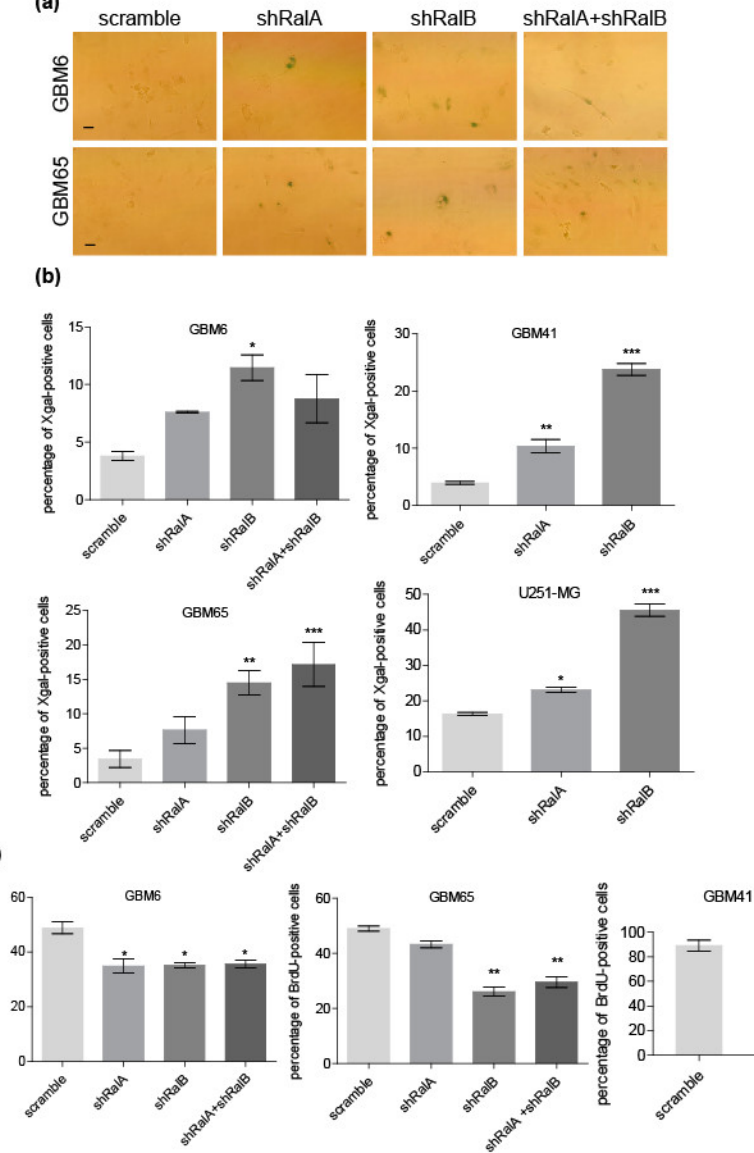
Figure 4. Downregulation of Ral GTPases promotes a senescence-like response in glioblastoma cells. Ral GTPases RalA and RalB were downregulated by RNA interference—shRalA and shRalB, respectively. Scramble shRNA was used as a control. GBM cells were infected by lentiviral vectors harboring the shRNAs. Five days after infection, cells were processed for senescence analyses. ( a ) Representative images of X-gal senescence assay. Blue cells indicate positive senescent cells (25 μm bar). ( b ) Quantification of senescence assay in ( a ) as a percentage of positive cells versus total cells. Values represent mean ± SEM. Significance was determined by ANOVA and Tukey post-test ( p ≤ 0.05, *; p ≤ 0.01, **; p ≤ 0.001, ***). ( c ) Quantification of BrdU incorporation assay. Values represent the percentage of BrdU-positive nuclei. The number of total nuclei was determined by counting nuclei stained with Hoechst. The mean ± SD ( n = 3) is shown. Significance was determined by ANOVA and Tukey post-test. Significance of scramble versus shRalA, shRalB, or shRalA + shRalB groups is represented ( p ≤ 0.05, *; p ≤ 0.01, **).